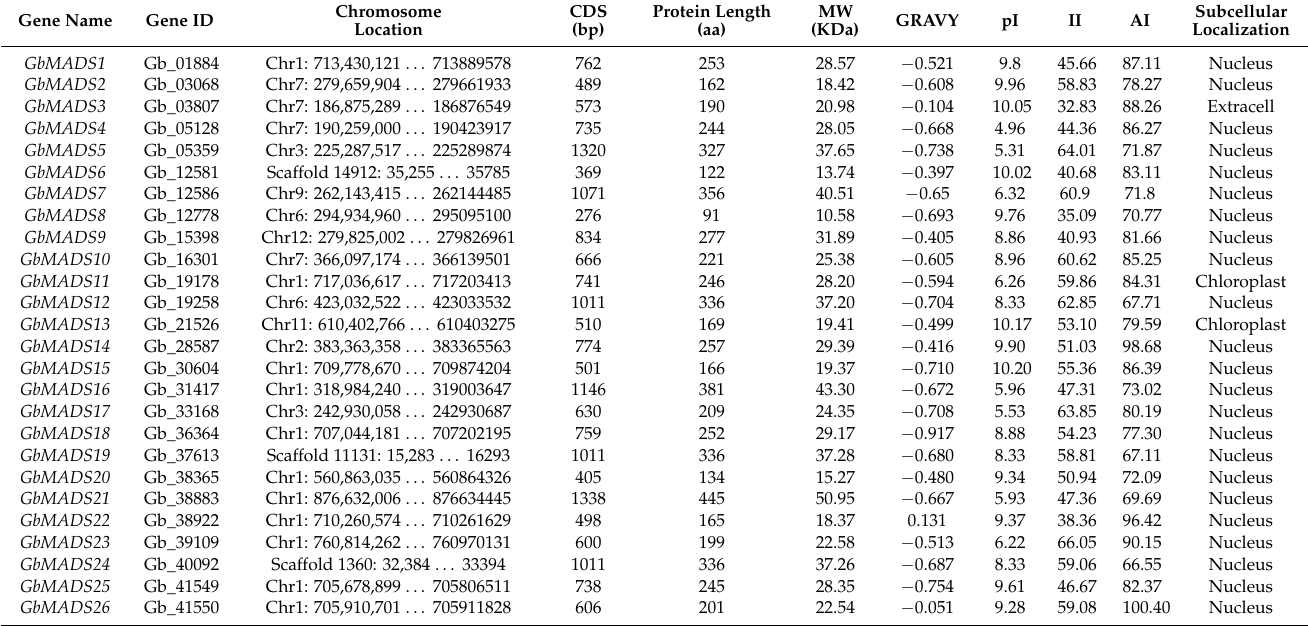
Table 1. Basic information of MADS-box family members in G. biloba